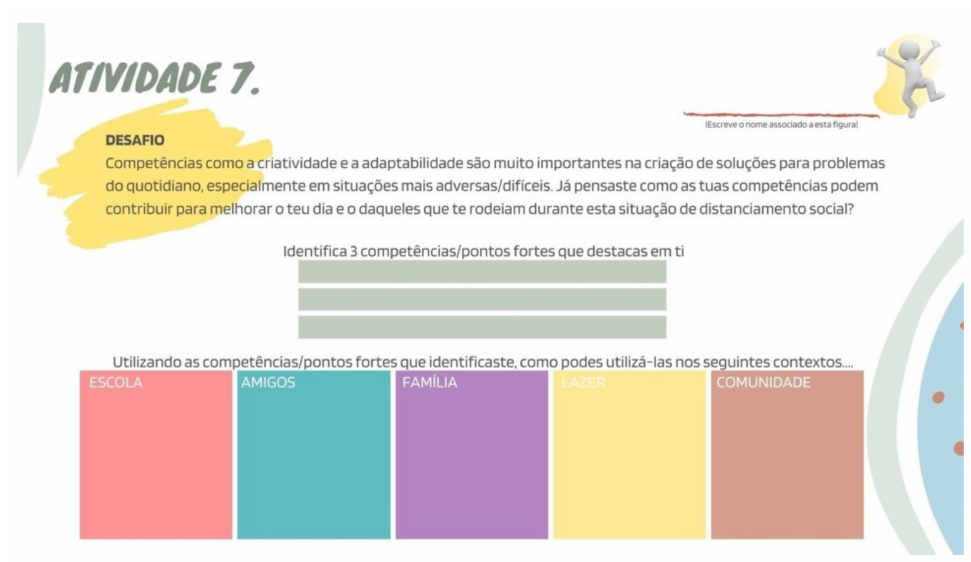
Figure 3. Example of suggested activity.